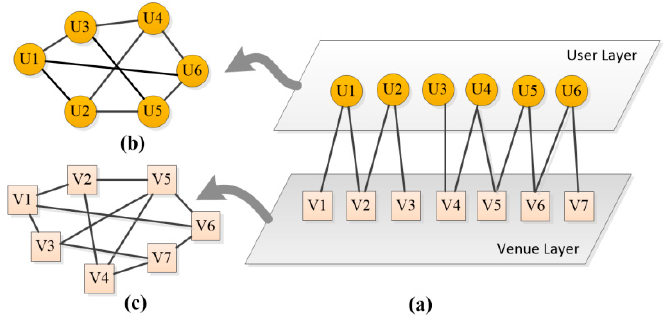
Figure 2. Graph models: ( a ) User location graph; ( b ) User neighborhood graph; ( c ) Location neighborhood graph.